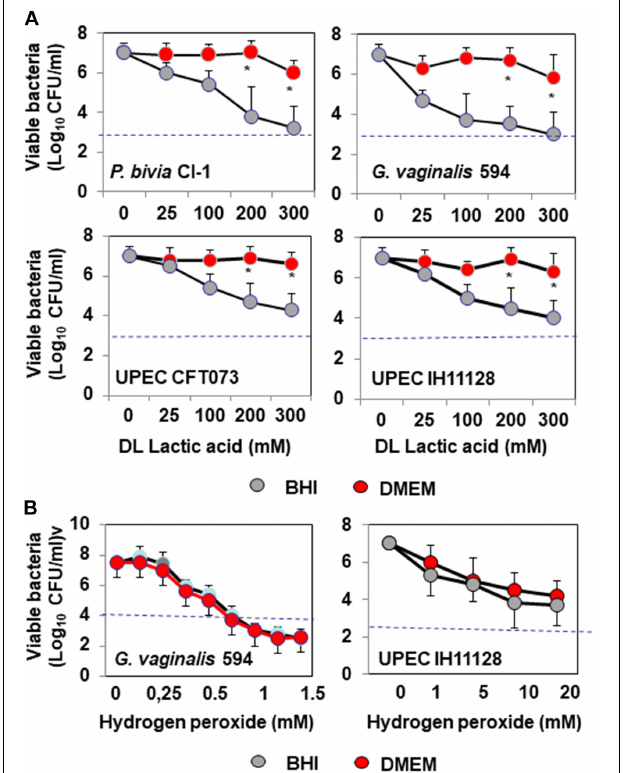
FIGURE 1 | In vitro lactic acid-dependent and -independent killing activity by direct contact against BV-associated P. bivia CI-1 and Gardnerella. vaginalis 594 strains, pyelonephritis-associated E. coli strain CFT073, and recurrent cystitis- and preterm labor-associated E. coli strain IH11128. (A) Concentration-dependent killing activity of DL-lactic acid in BHI or DMEM. (B) Concentration-dependent killing activity of hydrogen peroxide in the presence of BHI or DMEM. Each value shown is the mean ± SD from three experiments. Student t -test, ∗ p < 0.01 compared to BHI. The dotted line shows the MBE 99 . 99% value, defined as a reduction in the viable cell count of 4 log 10